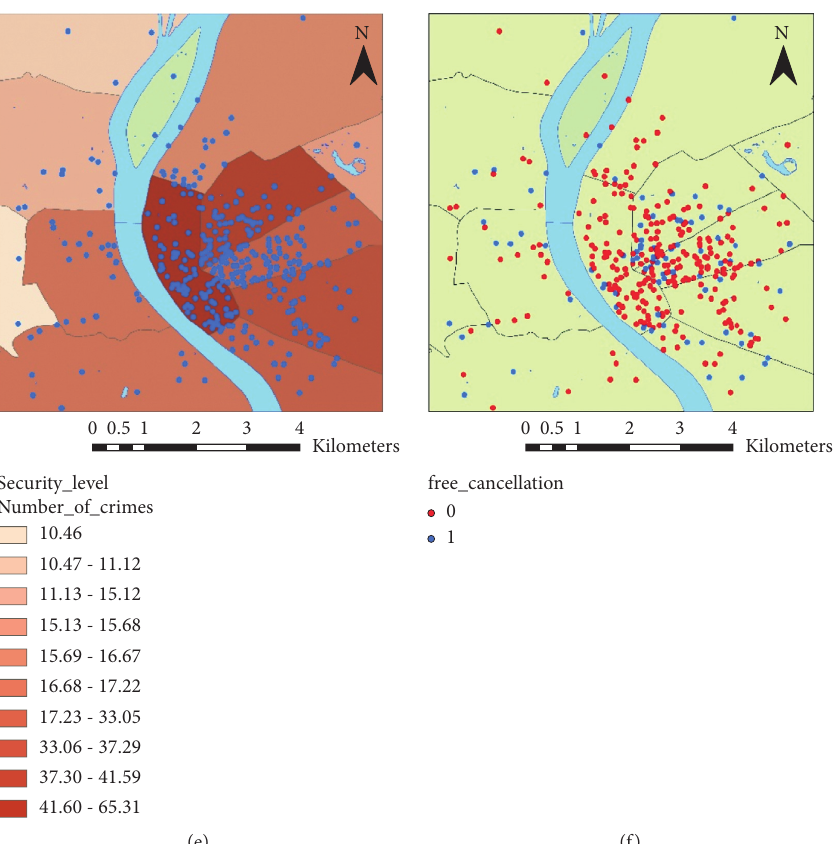
Figure 6: The classification of the alternatives in the study area. (a) Place rating. (b) Cost per room. (c) Distance from center result map. (d) Breakfast availability. (e) Level of security. (f) Free cancellation